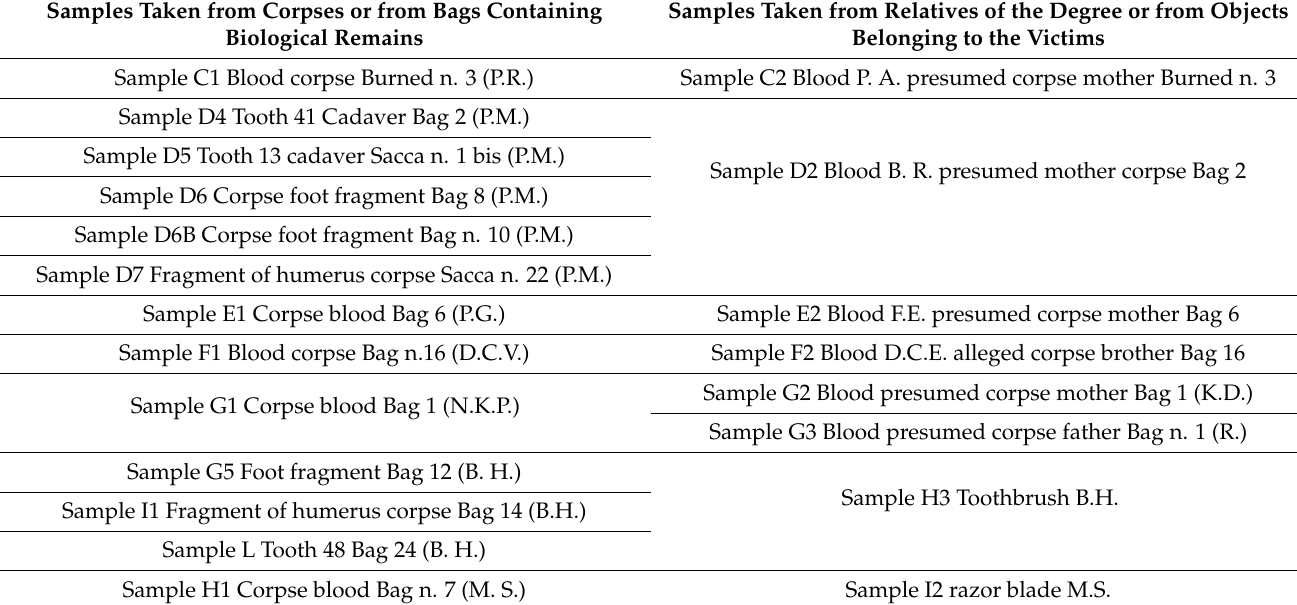
Table 1. Summary of the samples taken and used in the work. Samples Taken from Corpses or from Bags Containing Samples Taken from Relatives of the Degree or from Objects Biological Remains Belonging to the Victims Sample C1 Blood corpse Burned n. 3